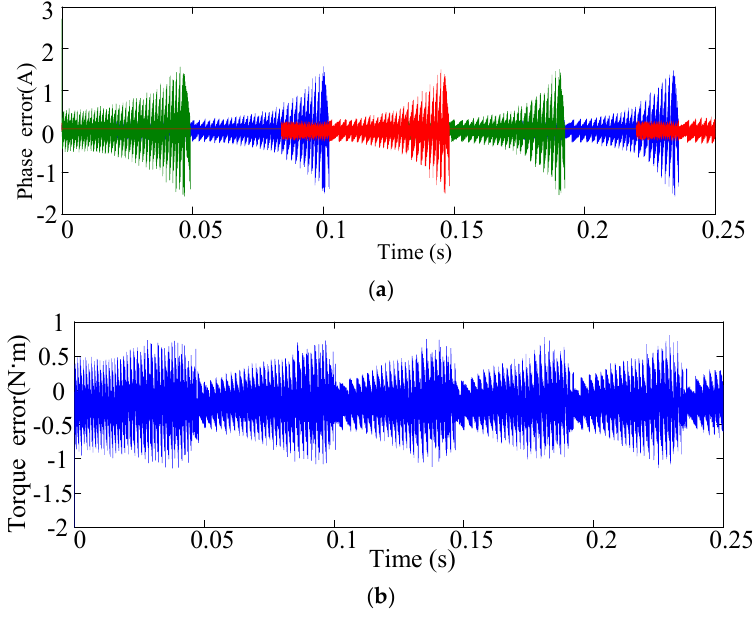
Figure 11. Simulation results when using CCC method based on linear TSF (band is set 0.1, reference torque is set 3.7 N · m and sample time is set 1 × 10 − 5 s), ( a ) Phase current error ( b ) Torque error.